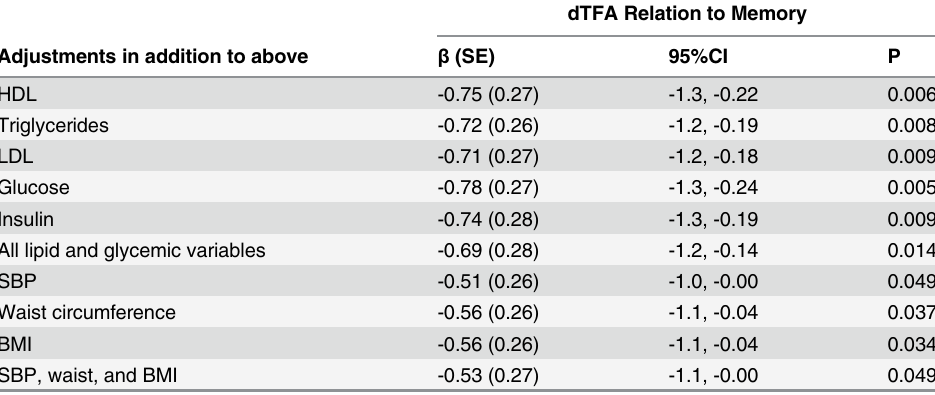
dTFA Relation to Memory